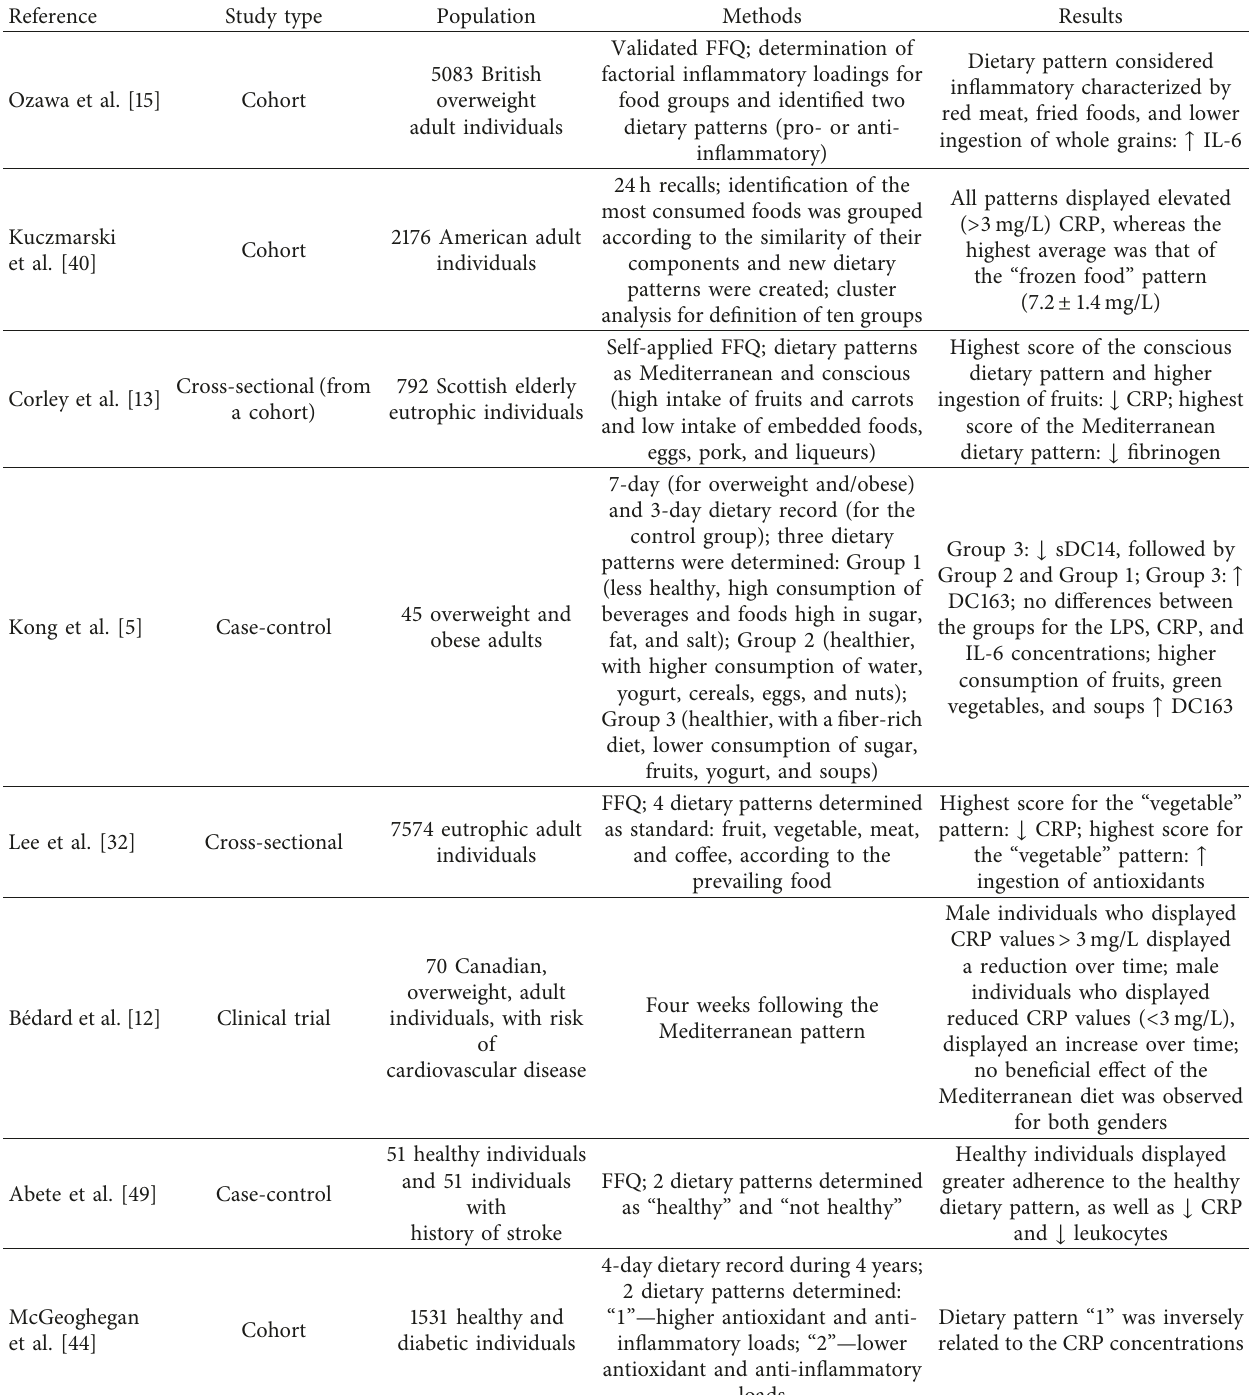
Table 2: Studies that assessed the effect of dietary patterns on the chronic subclinical